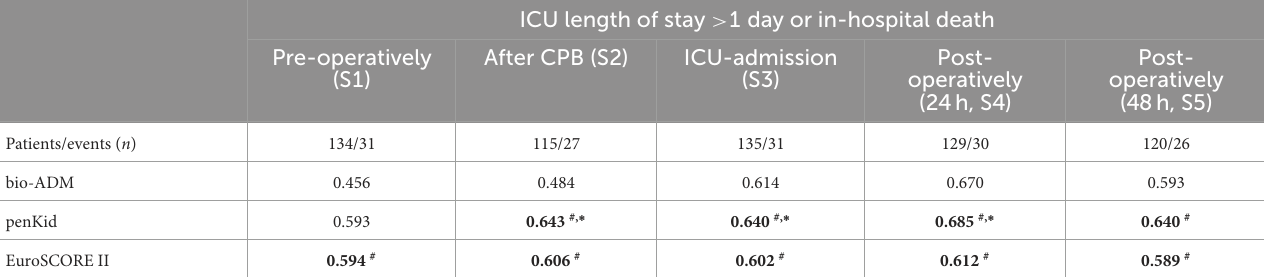
TABLE 2 AUC analysis of serial penKid and bio-ADM and the combined outcome “ICU length of stay > 1 day or death in